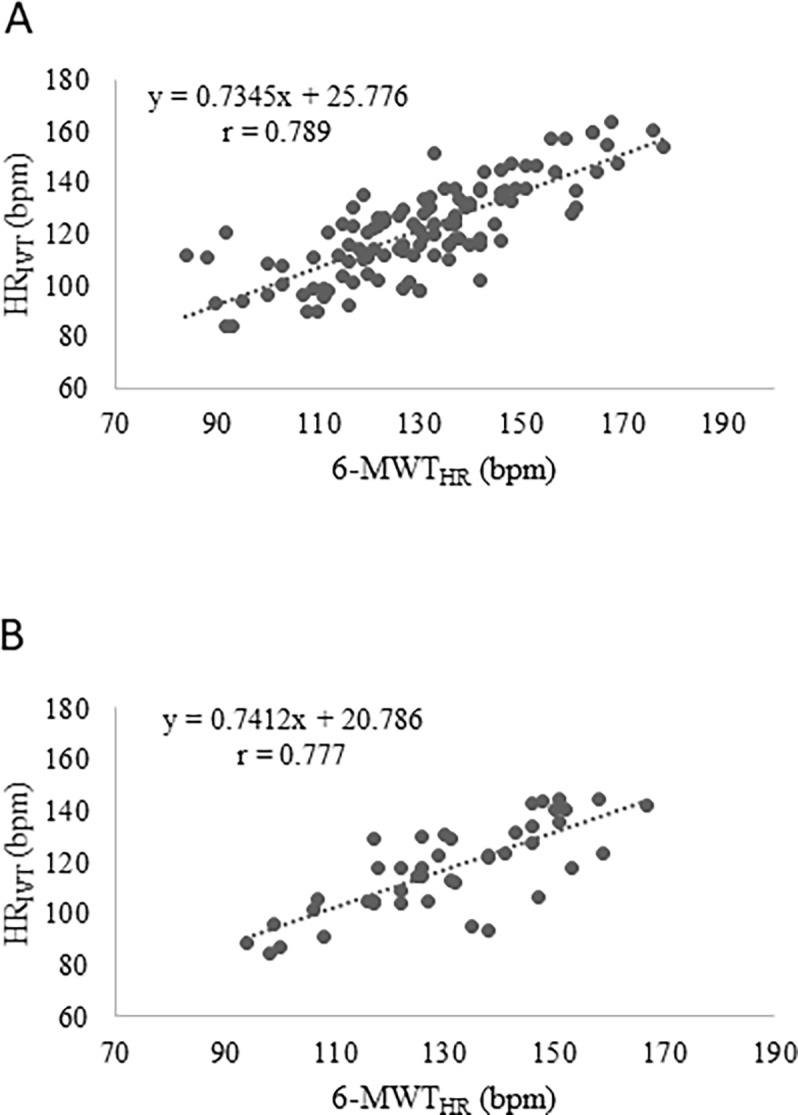
Scatterplot of HR at IVT (HRIVT) to mean HR during 6-MWT (6-MWTHR) for females (A) and males (B).